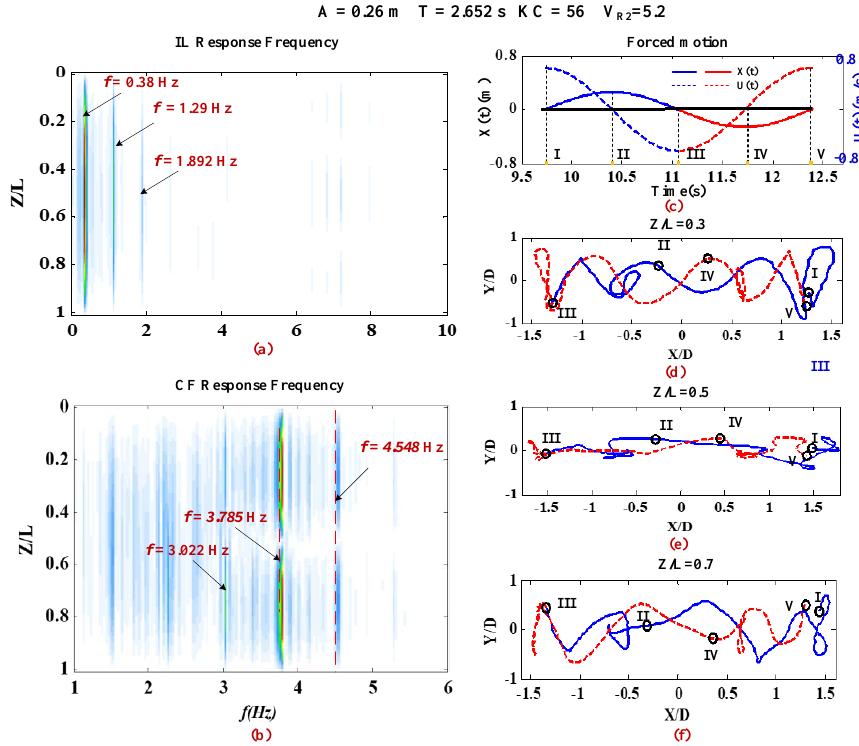
Figure 16. The spatial distribution of response frequency and displacement trajectories at different positions when KC = 56 and V R2 = 5.2.